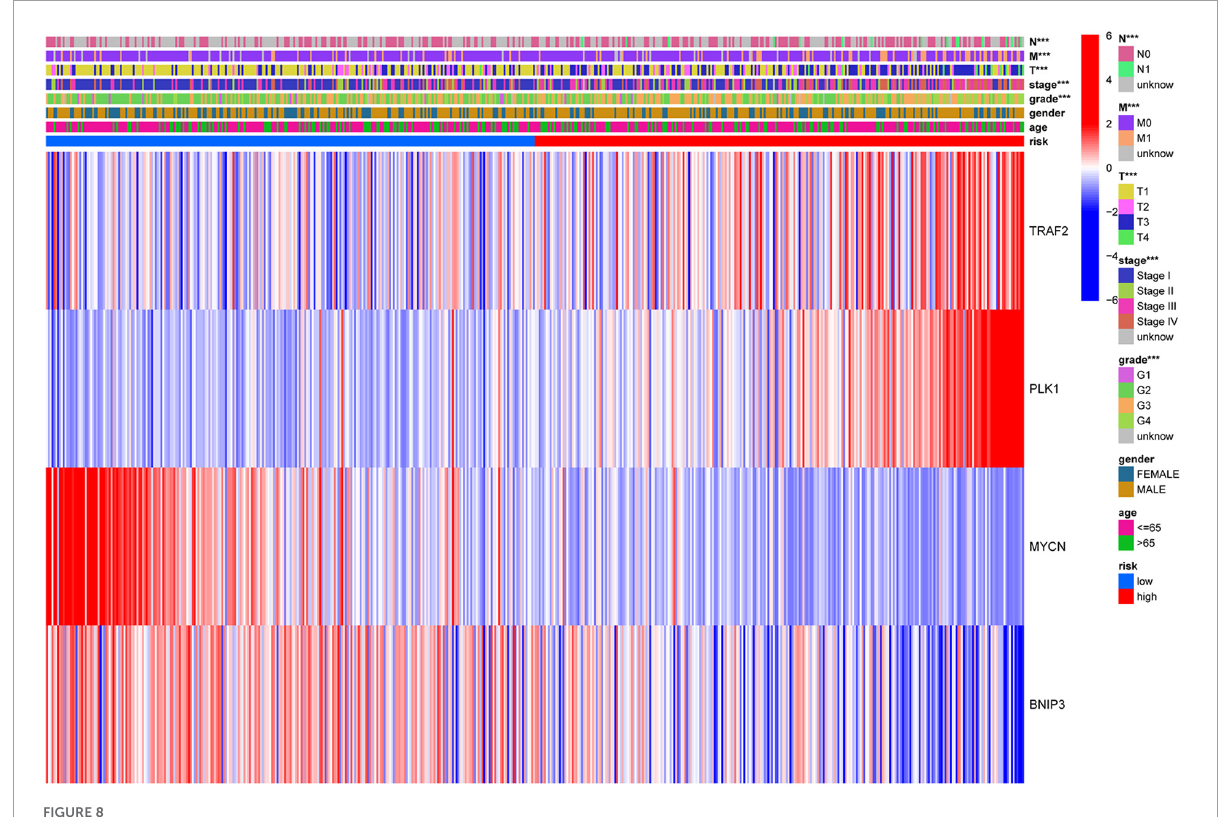
FIGURE8 Correlation of risk group and clinicopathological characteristics. *** p < 0.001.